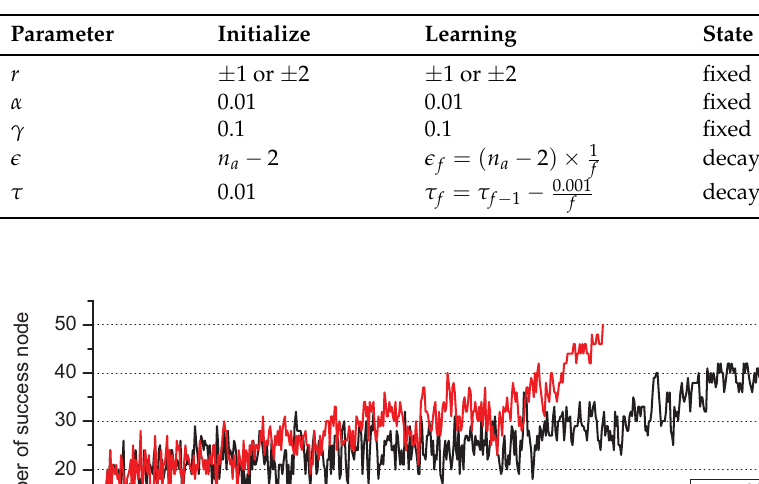
Simulation parameters for Collaborative Reinforcement Learning Protocol (CoRL)